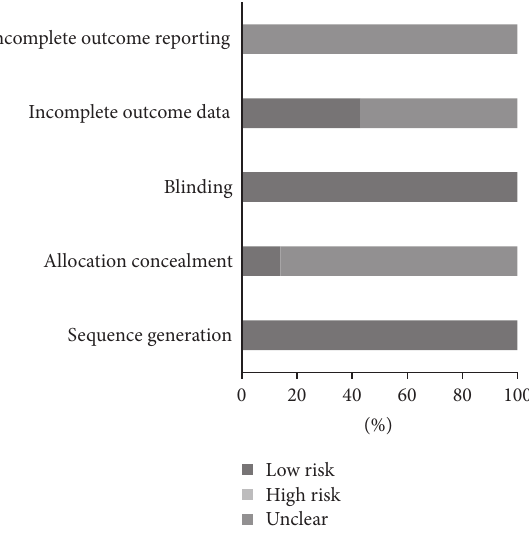
F 1: Risk of bias. Pooled risk of bias results using the Cochrane Risk of Bias Assessment Tool